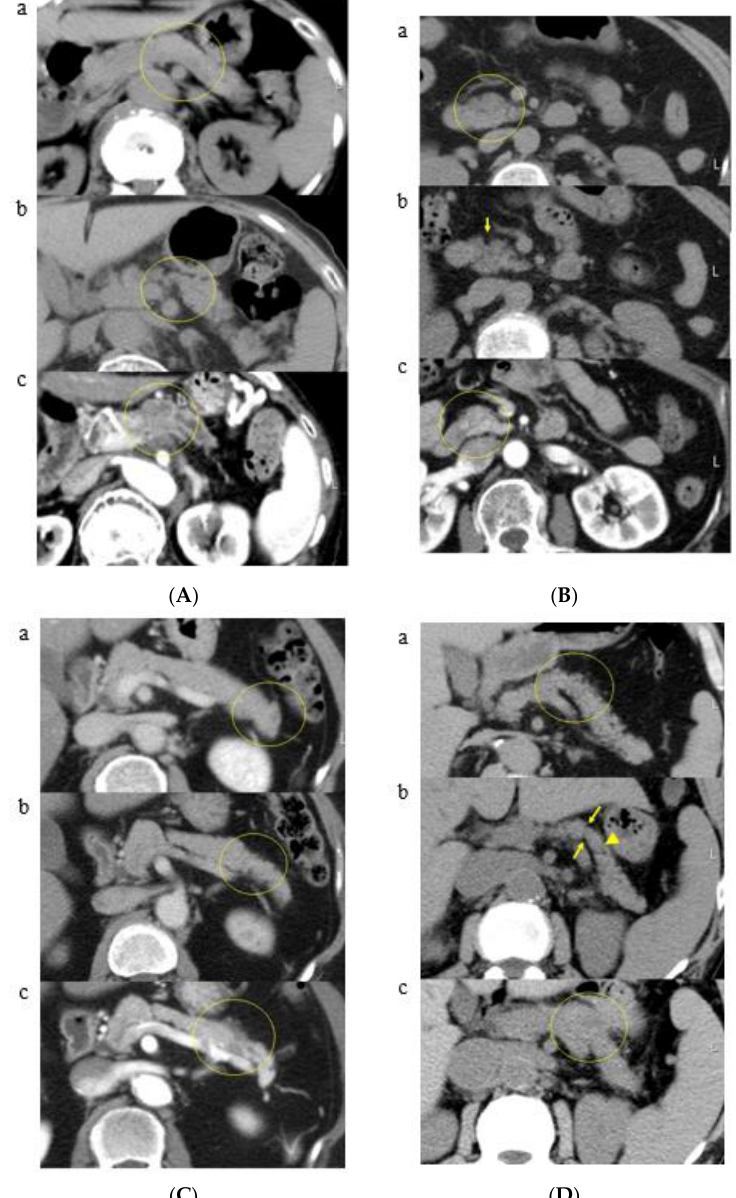
Figure 4. ( A ) Group A (a representative patient with K-sign in the pancreatic body): ( a ) April 2005: pancreatic body shows no evidence of pancreatic abnormality (a yellow circle); ( b ) January 2013: K-sign is shown in the pancreatic body (a yellow circle); ( c ) December 2016: pancreatic body cancer with main pancreatic duct dilatation is shown in the K-sign area (a yellow circle). ( B ) Group A (a representative patient with K-sign in the pancreatic head): ( a ) May 2004: pancreatic head looks normal on this CT (a yellow circle); ( b ) September 2012: K-sign is shown in the pancreatic head (a yellow arrow), ( c ) July 2013: pancreatic head cancer is developed at the site of K-sign (a yellow circle). ( C ) Group A (a representative patient with K-sign in the pancreatic tail): ( a ) October 2007: K-sign is shown in the pancreatic tail (a yellow circle); ( b ) October 2011: K-sign expanded compared with the previous CT in 2007 (a yellow circle); ( c ) August 2012: pancreatic tail cancer with main pancreatic duct dilatation is shown (a yellow circle). ( D ) Group A (a representative patient with K-sign and patented main pancreatic duct): ( a ) March 2003: pancreatic body looks normal on this CT (a yellow circle); ( b ) August 2011: K-sign (a yellow arrow) and main pancreatic duct (a yellow triangle) are shown; ( c ) August 2013: pancreatic body cancer is shown at the site of K-sign (a yellow